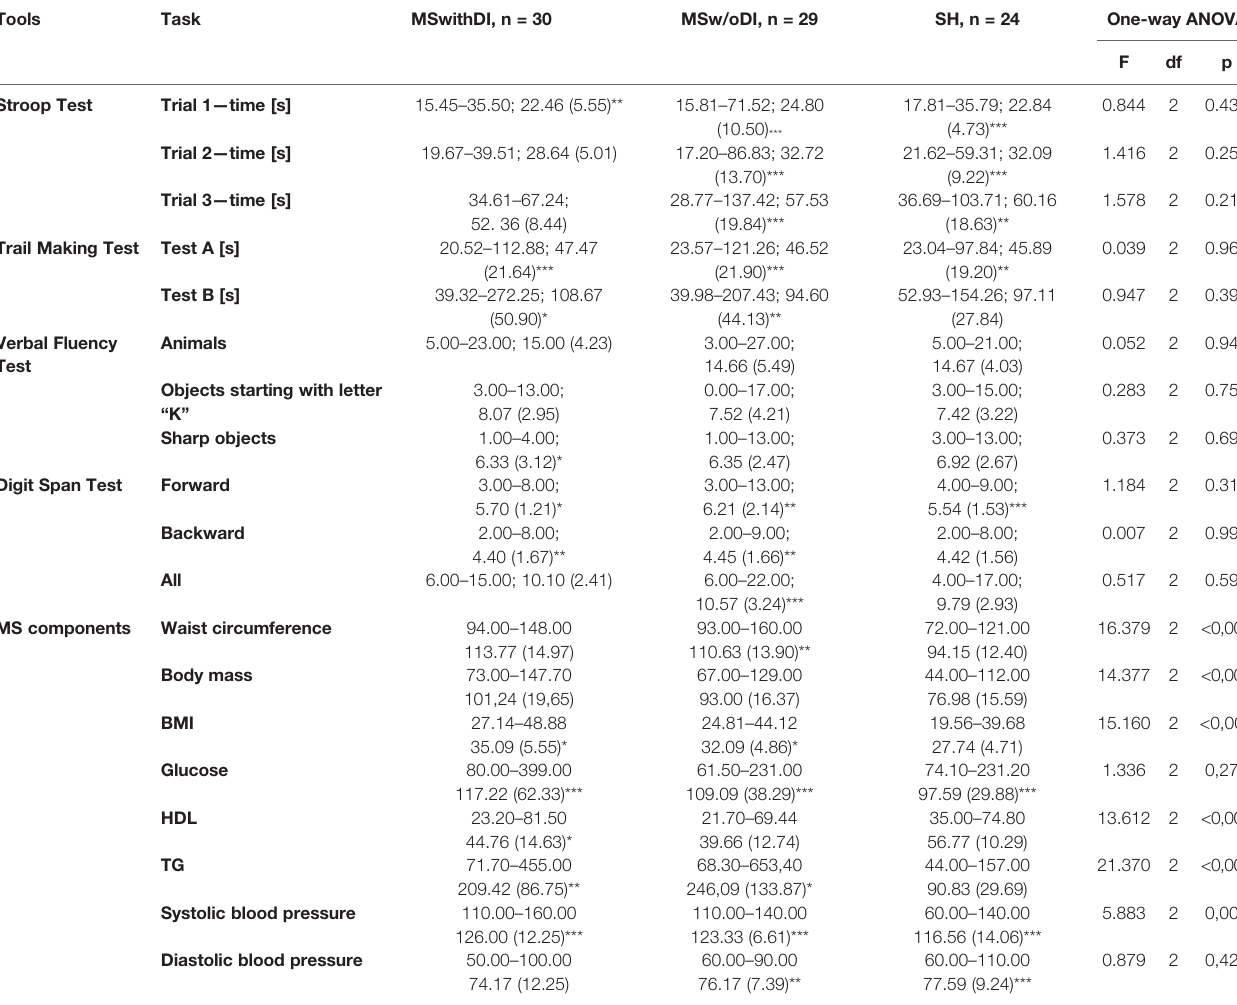
TABLE 2 | Results of cognitive function and results allowing for diagnosis of metabolic syndrome measurement before dietary intervention; min – max; M (SD). Tools